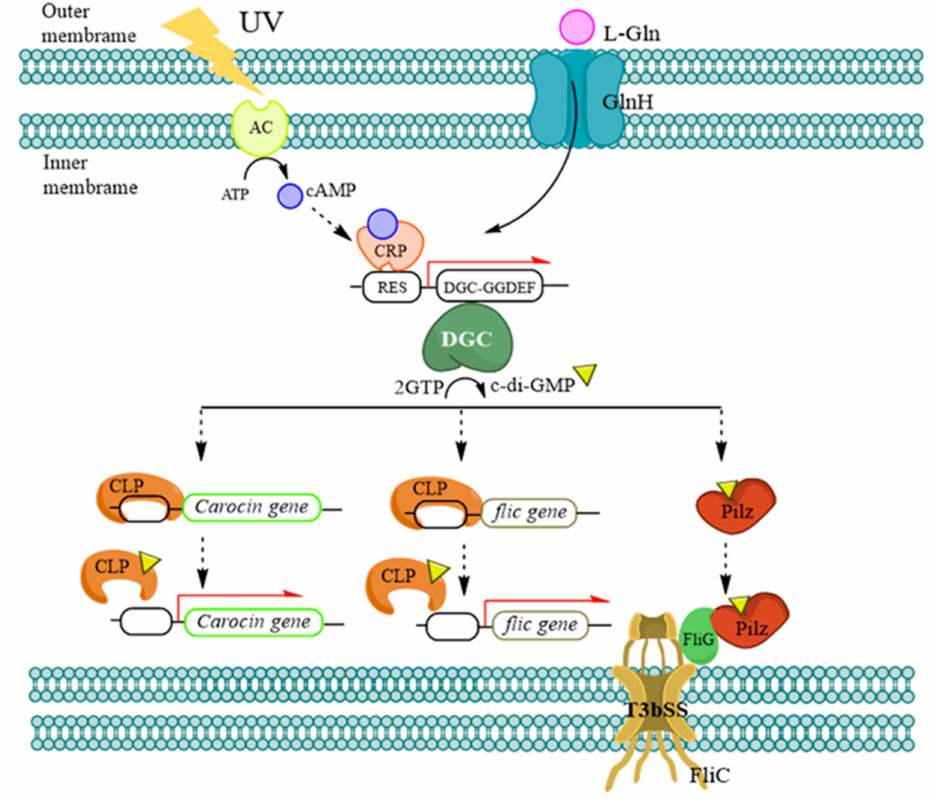
Figure 5. DGC and bacteriocin regulation, synthesis, and secretion: a proposed molecular